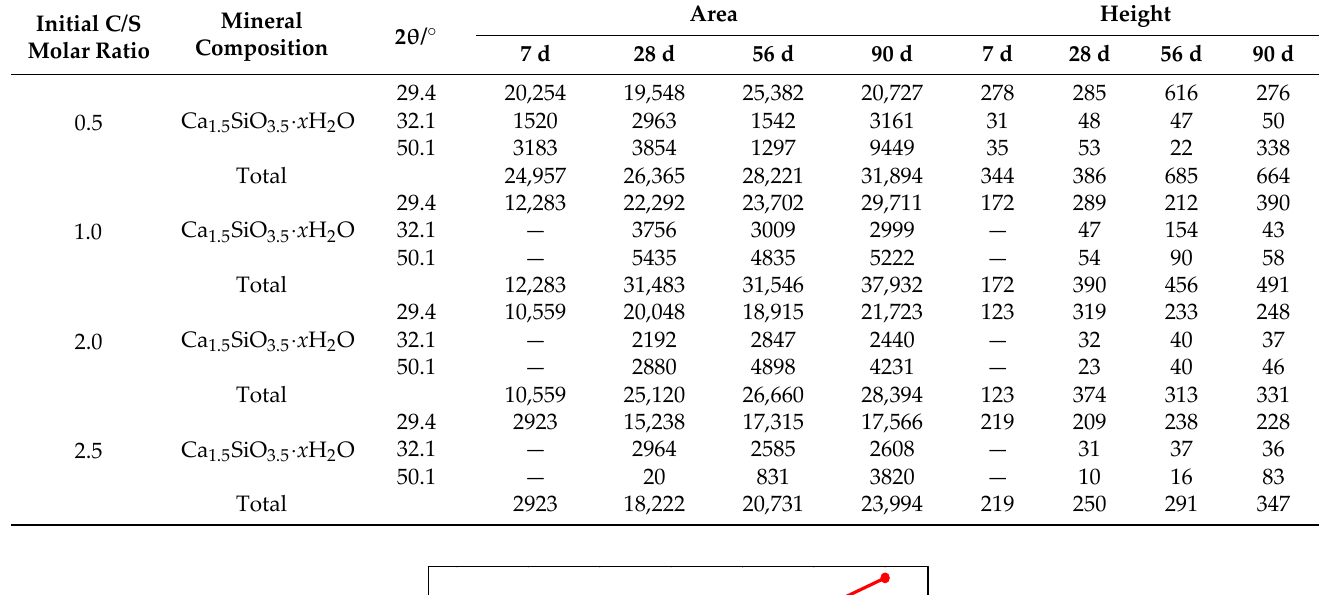
Table 3. XRD peaks of C‑S‑H.